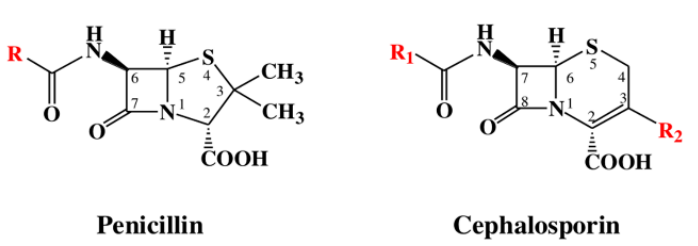
Figure 1. The structures of penicillin and cephalosporin. The β -lactam scaffolds are shown in black, and the different side chain structures of β -lactam are shown as R in red.